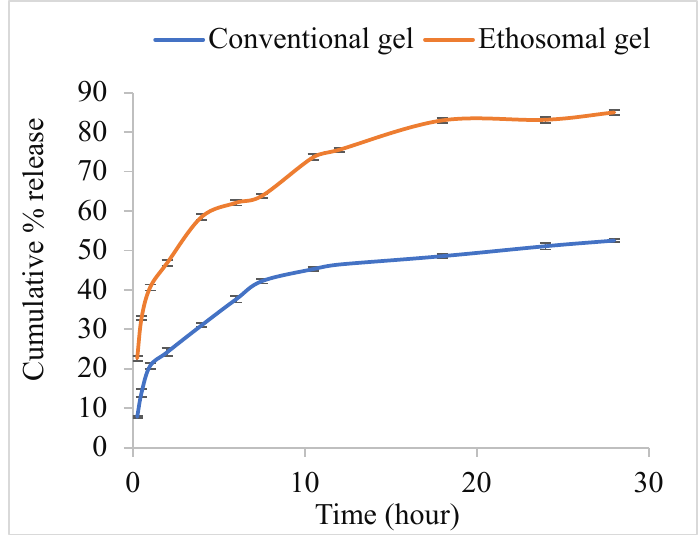
Figure 8. In vitro release study profile of TEF-loaded conventional gel and TEF-loaded ethosomal gel. Each study was performed in triplicate and data are shown as mean ± SD. A comparison of the release profile of both gels is shown with an initial burst release followed by a sustained release pattern.